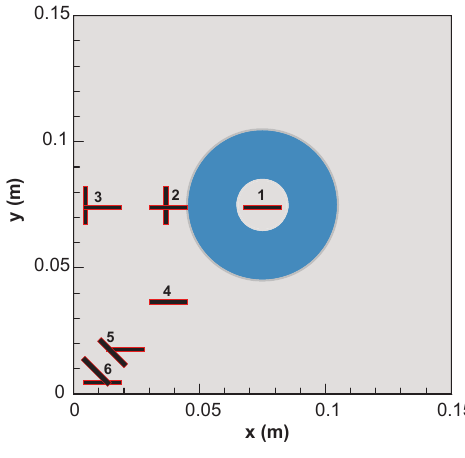
Figure 4. Crack positions in the plate (the coil is placed above the plate center at the optimum distance, i.e. , z =10